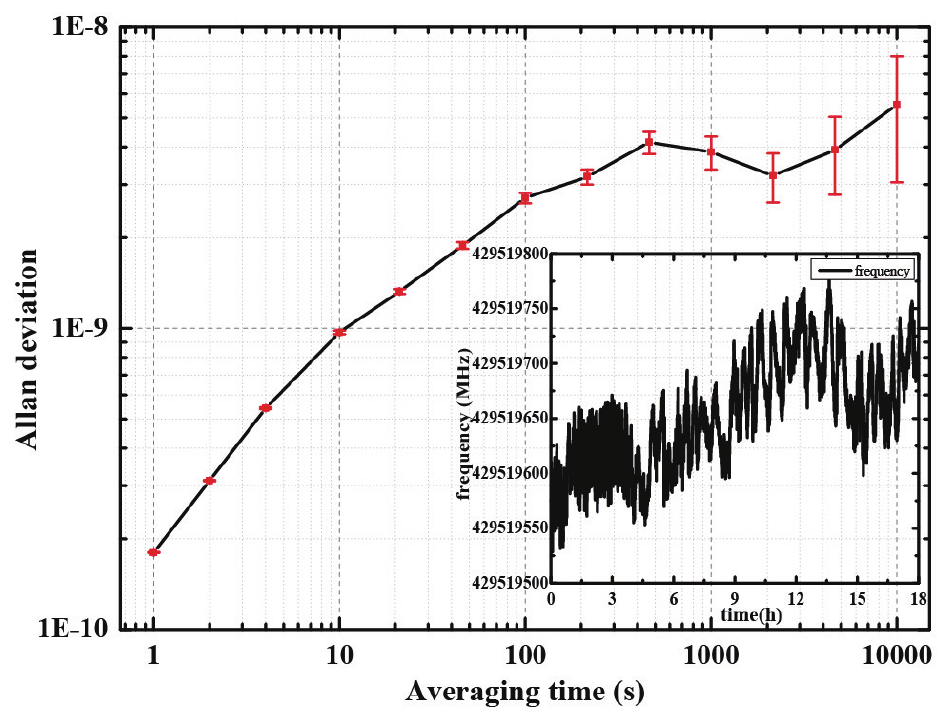
Figure 9. Long-term frequency fluctuations of the free-running 698 nm ECDL.